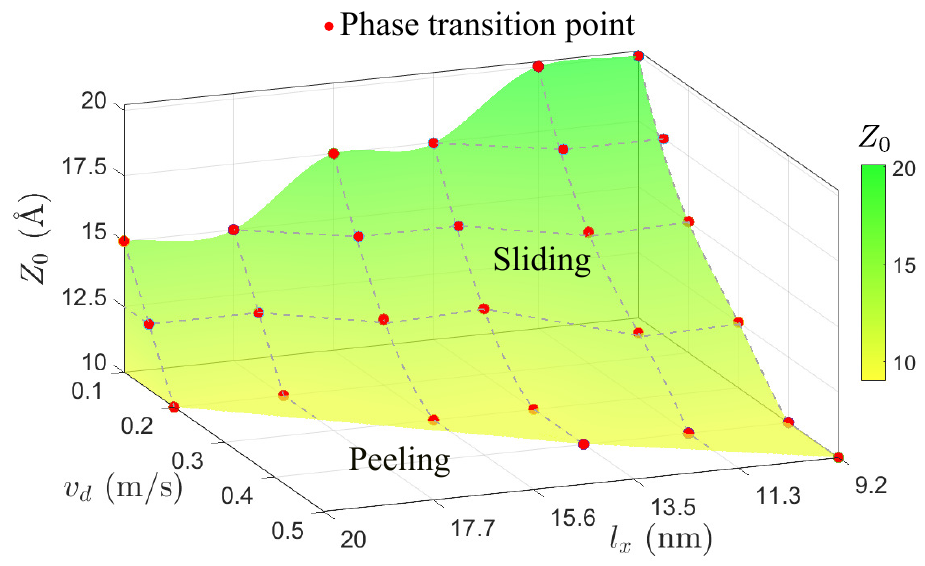
Figure 5. Phase diagram of sliding and peeling responses. With the rise of l x and v d , peeling behavior becomes energetically